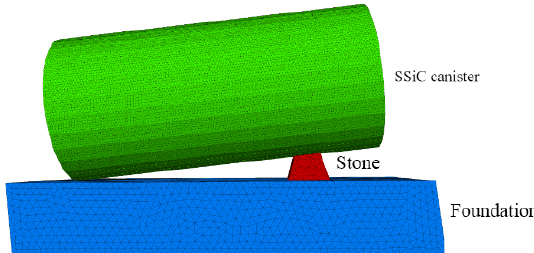
Figure 15. Geometry of static point load model. Table 10. Constitutive parameters for matrix.